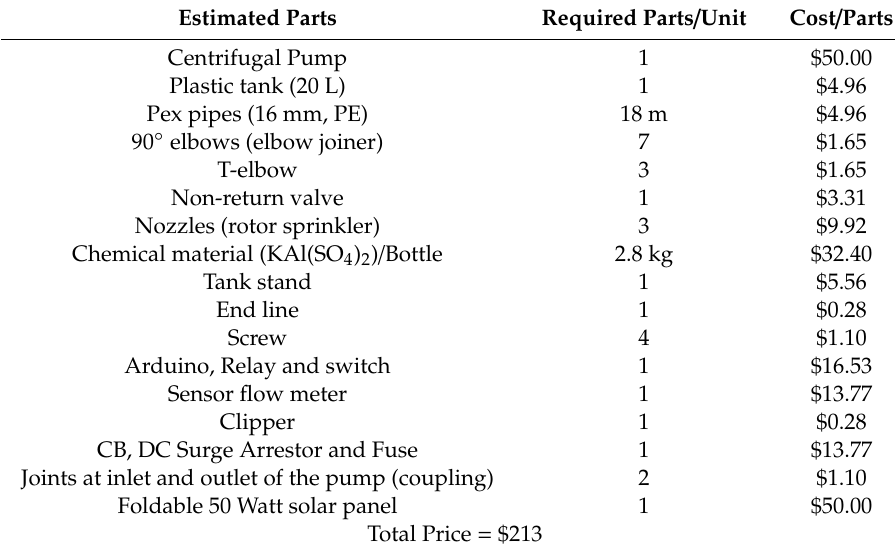
Table 2. Proposed device cost.